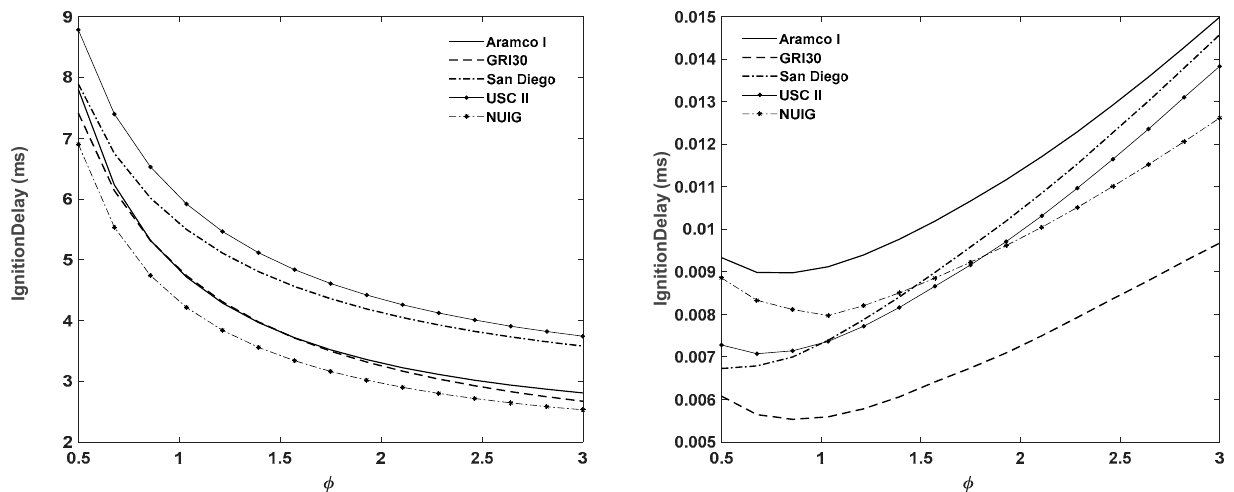
Figure 9. Ignition delay time calculated from all mechanisms at p = 40 bar and at different equivalence ratio values for methane/syngas mixture, left : T = 1000 K; right : T = 1600 K.